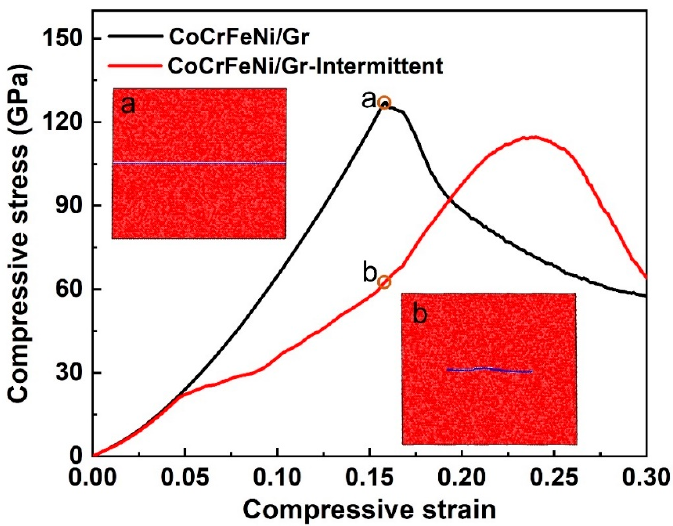
Figure 7. The calculated compressive stress–strain curves of NL CoCrFeNi/Gr composites with continuous graphene and intermittent graphene inserted with the corresponding configurations of graphene at 15.9% compressive strain.